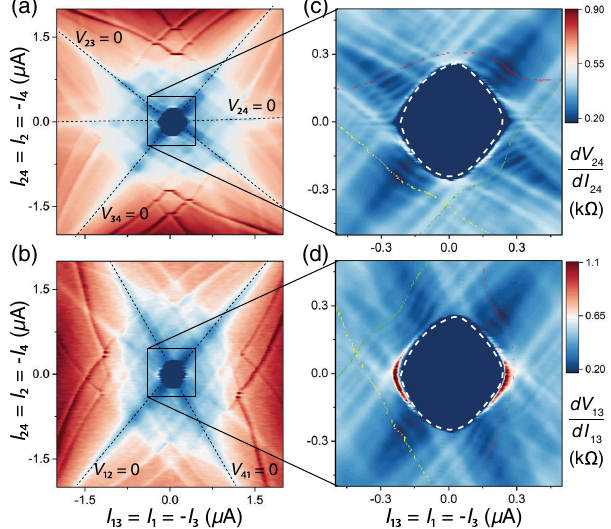
FIG. 3. Transport in a four-terminal junction. (a),(b) Differ- ential resistance across the terminal pair (2,4) and (1,3) in the device shown in Fig. 1(d). (c),(d) Enlargement of the zero-voltage region. The CCCs are marked by a white dashed line as a guide to the eye. The six radial features represent the conditions V 12 ¼ 0 , V 23 ¼ 0 , etc., as marked directly on the plots. The colored lines represent some of the MAR conditions. (c) Red, eV 24 ¼ 2 Δ =n ; yellow, eV 23 ¼ 2 Δ =n ; green, eV 34 ¼ 2 Δ =n . (d) Red, eV 13 ¼ 2 Δ =n ; yellow, eV ¼ 2 Δ =n ; green, eV ¼ 2 Δ =n . Here Δ ≈ 41 12 160 μ eV and n ¼ 5